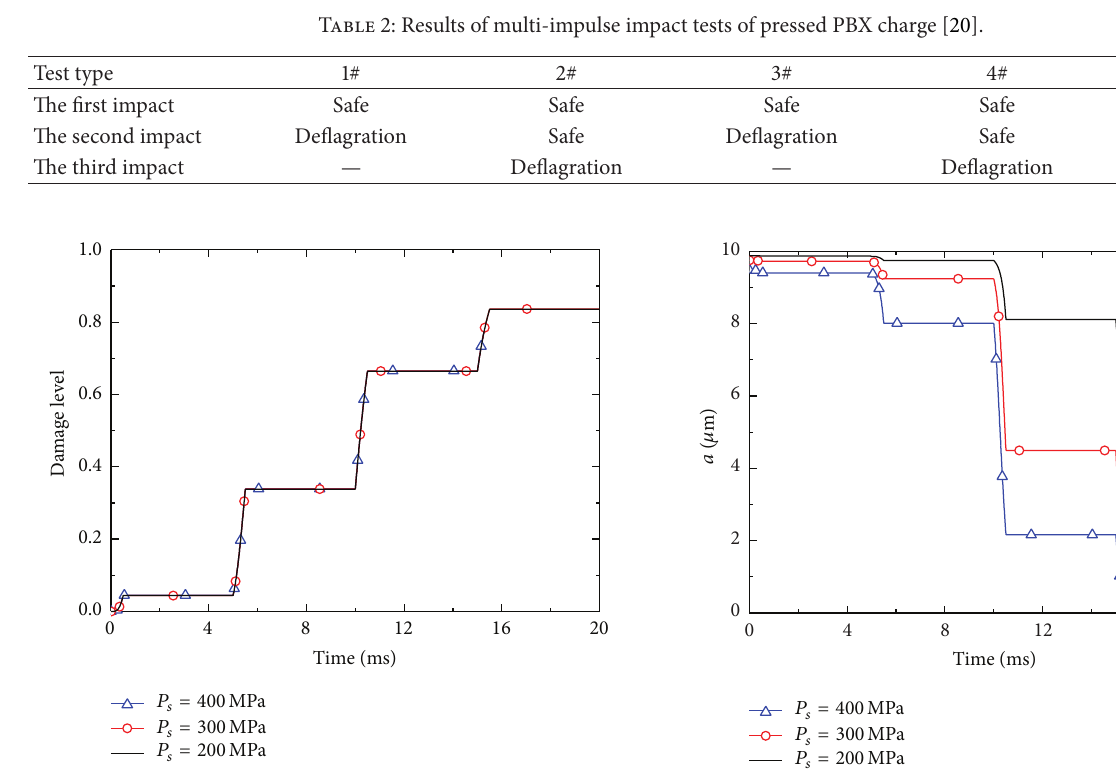
Figure 10: Time evolution of pore radius when the explosive was loaded by four repeated